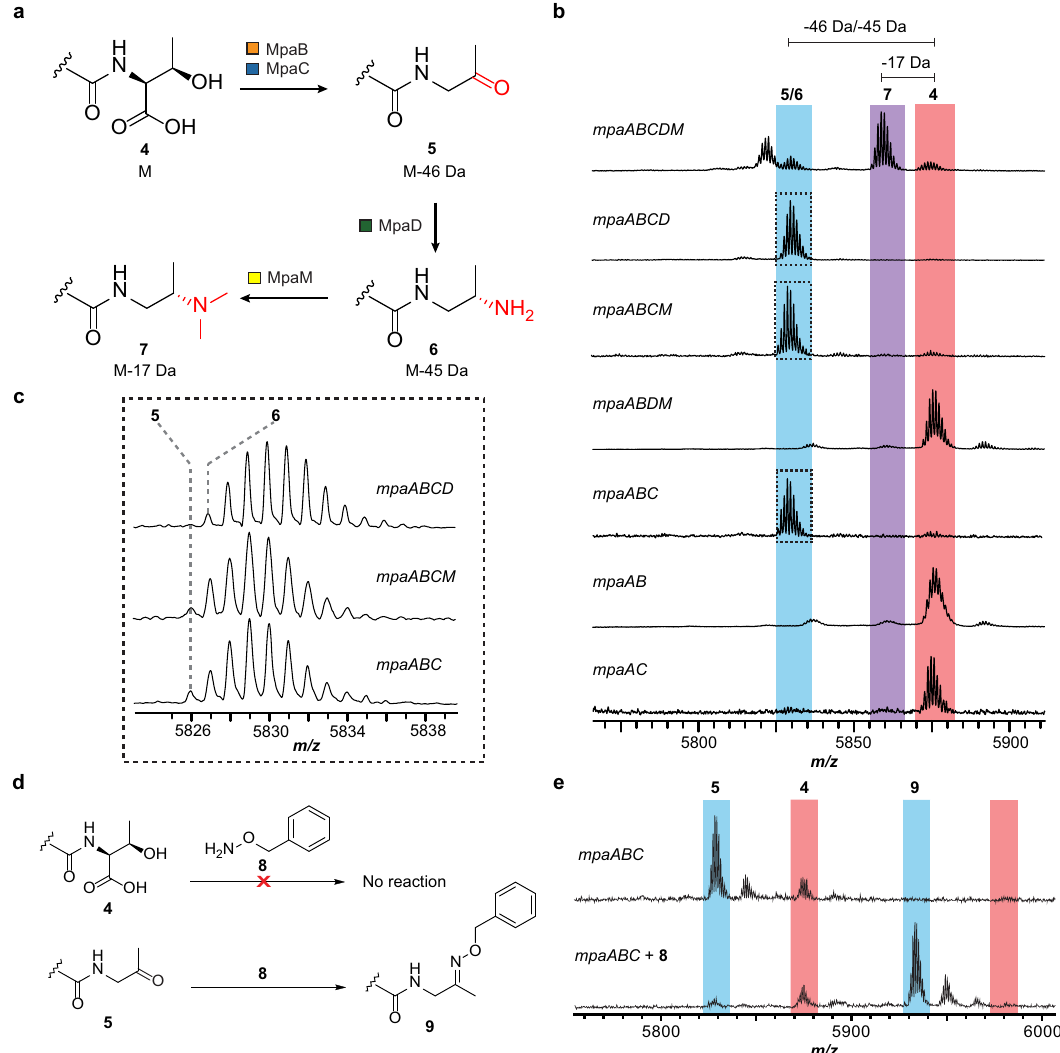
Fig. 3 | Characterization of the biosynthetic pathway. a Proposed biosynthetic route for the Dmp modi fi ed C -terminus. b MALDI-TOF mass spectra of IMAC- puri fi ed MpaA1 that were co-expressed with the indicated Mpa biosynthetic pro- teinsin E.coli ( 4 , m/z 5872; 5 , m/z 5826; 6 , m/z 5827; 7 , m/z 5855). c EnlargedMALDI-